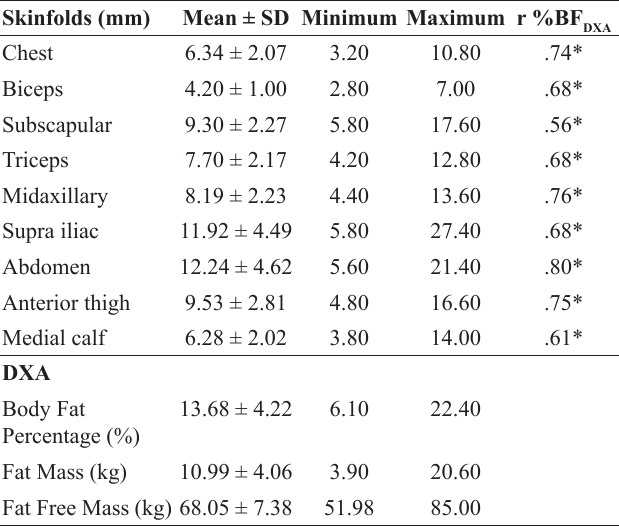
DXA: Dual-energy X ray Absorptiometry; * significant association with DXA, p < .001.